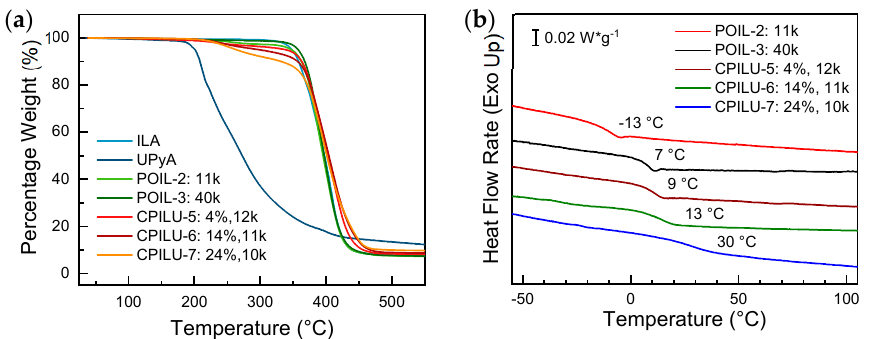
Figure 2. Thermal characterization of ionic monomer ILA , HBs monomer UPyA , homopolymers POIL-x , and copolymers CPILU-y via ( a ) thermogravimetric analysis measured at a heating rate of 10 K · min − 1 under N 2 atmosphere; and ( b ) differential scanning calorimetry measured at a heating rate of 5 K · min − 1 with the thermal history cancelled by a preheating/cooling circle (the baseline of POIL-3 was corrected manually).